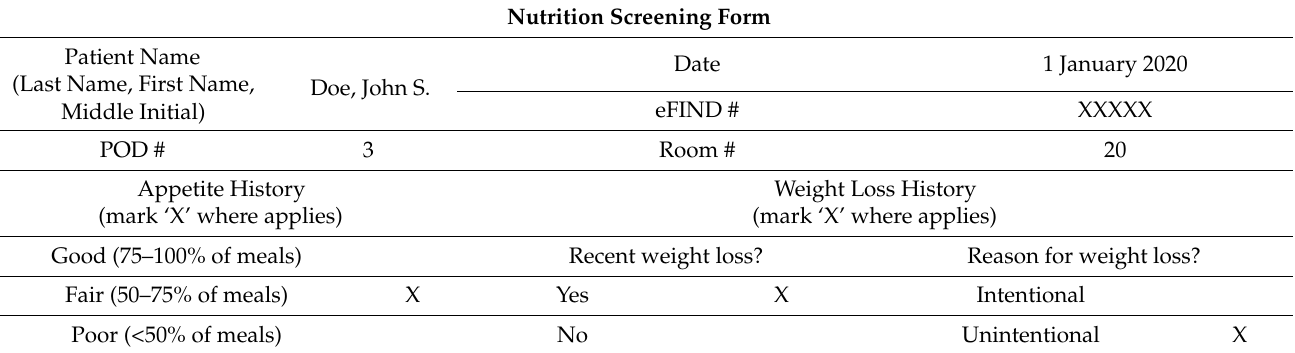
Table 4. An example ‘Nutrition Screening Form,’ designed to collect nutrition-related information on all patients simply and